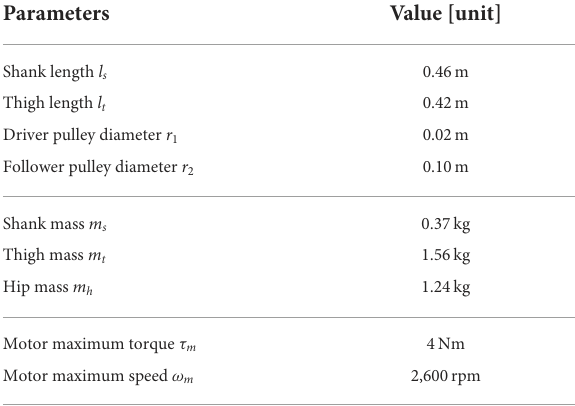
TABLE 1 Electric-pneumatic actuation (EPA)-Hopper physical